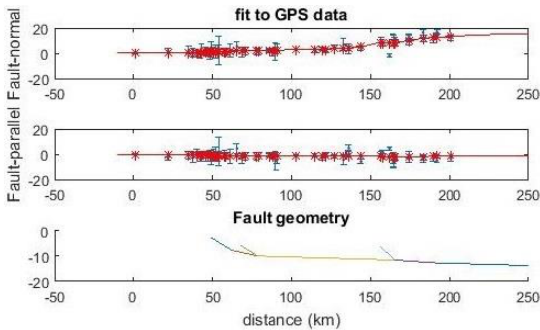
Figure 4 . Fit to the Fault-Normal and Fault-Parallel component after fixing THKD